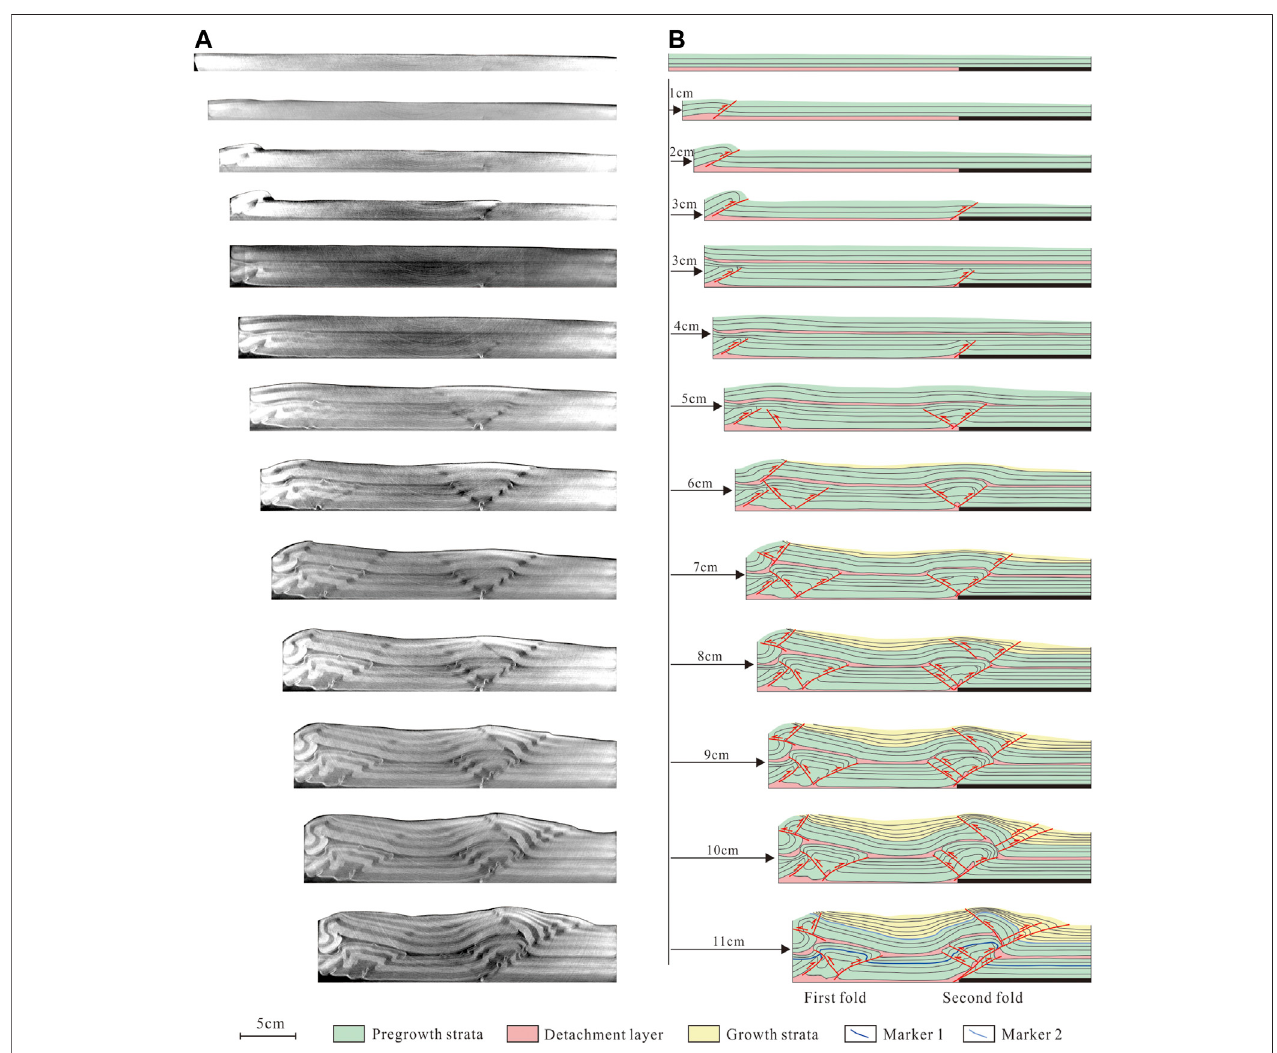
FIGURE 7 | X-ray images of structural evolution in the model after every 1 cm shortening (A) . Line drawings of the scanned images highlighting the main structural features (B) .